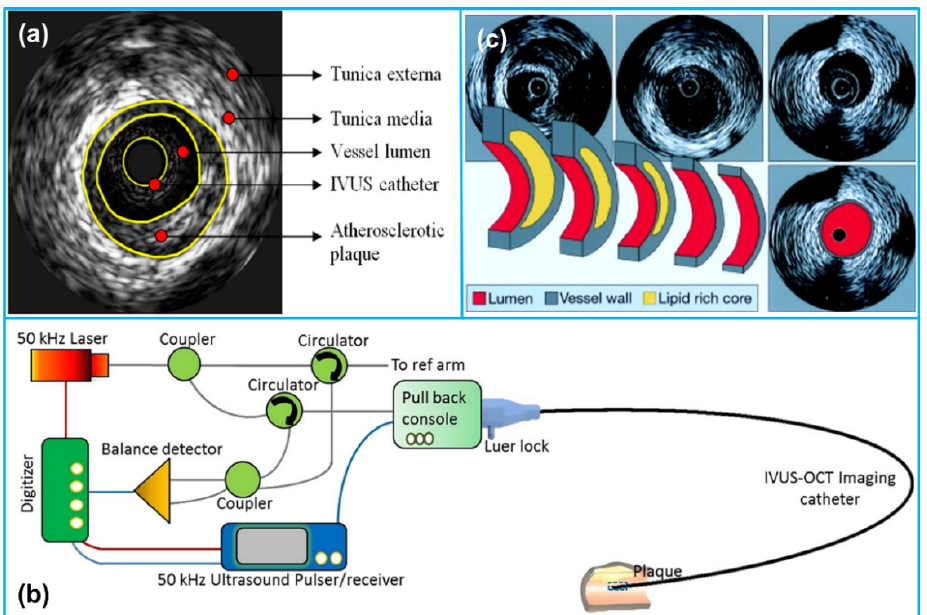
Figure 1. ( a ) A typical grayscale display of an arterial cross-sectional image acquired through in- travascular ultrasound (IVUS) imaging. Reprinted from [32] with permission. ( b ) An illustration of an IVUS imaging system composition. Reprinted from [33] with permission. ( c ) Series of tomo- graphic IVUS images acquired through the ultrasound transducer pullback. Reprinted from [30] with permission.